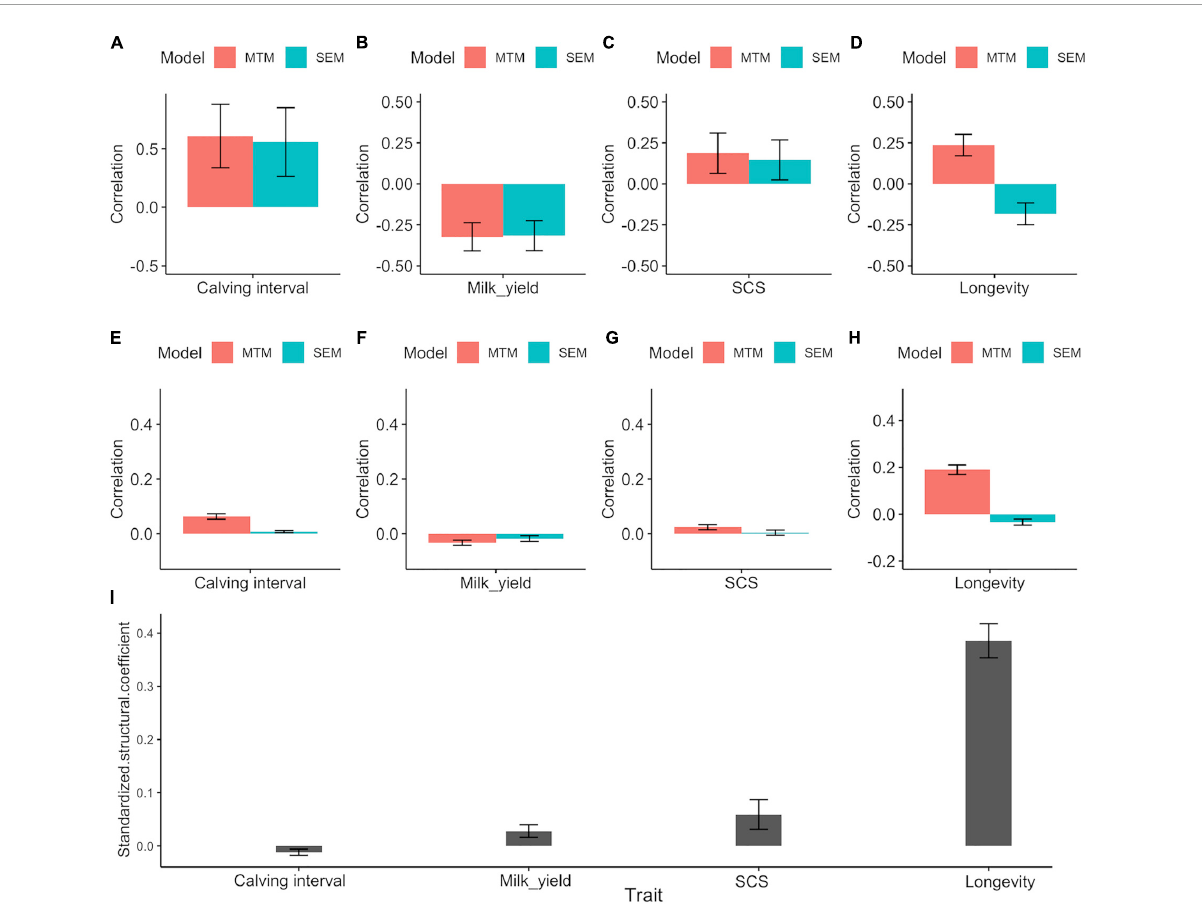
The 95% high posterior density regions (HPD95) for heritability are reported in brackets. σ 2 Pe , permanent environment variance; σ 2 a , additive genetic variance; σ 2 e , residual variance; CV A ,coefficientofadditivegeneticvariation; h 2 ,heritability.